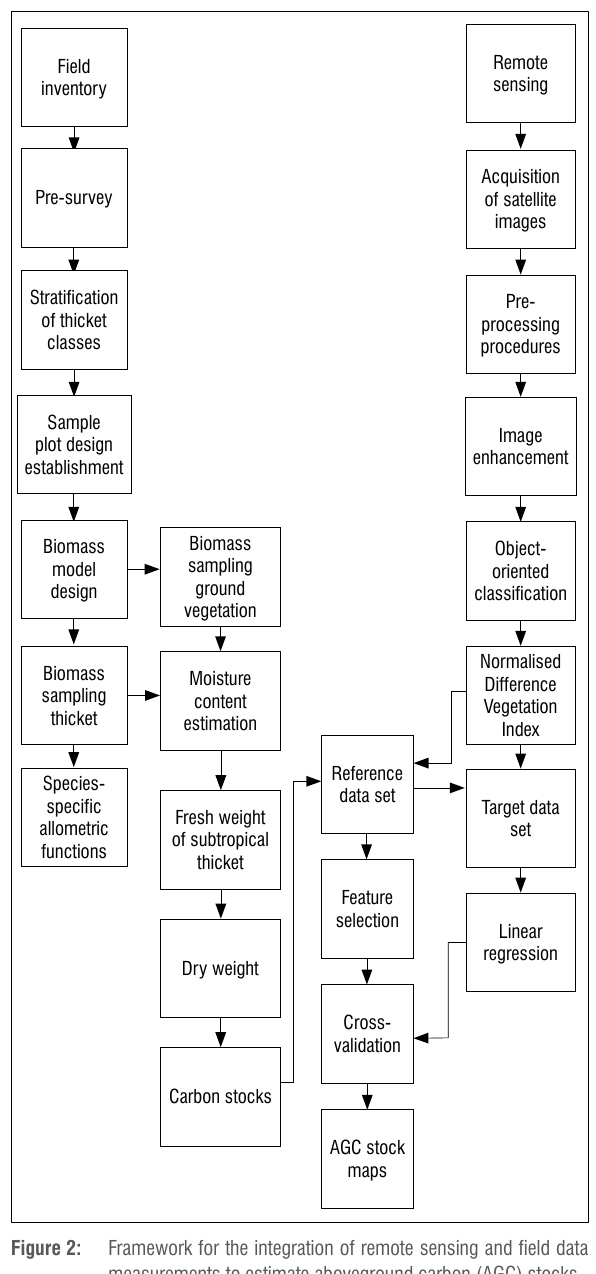
Figure 2: Framework for the integration of remote sensing and field data measurements to estimate aboveground carbon (AGC)